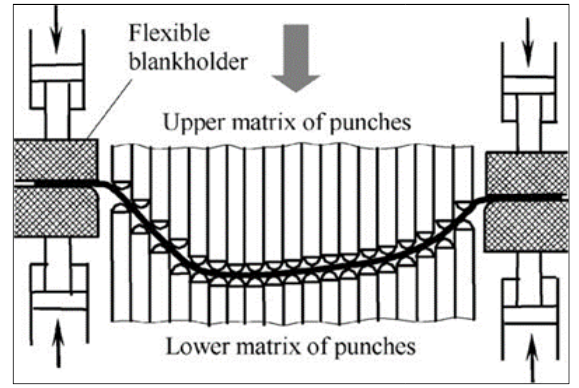
Fig. 1. Principle of multi point forming process